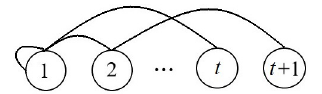
Figure 7. Graph describing growing random